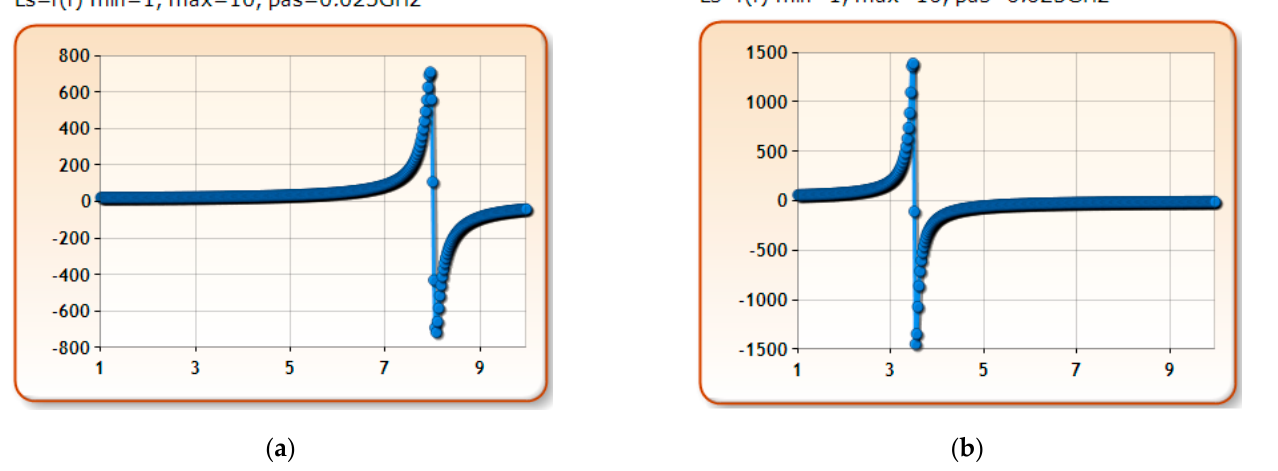
Figure 2. The inductance variation vs. frequency for: ( a ) 5 and ( b ) 8 turns spiral inductors.